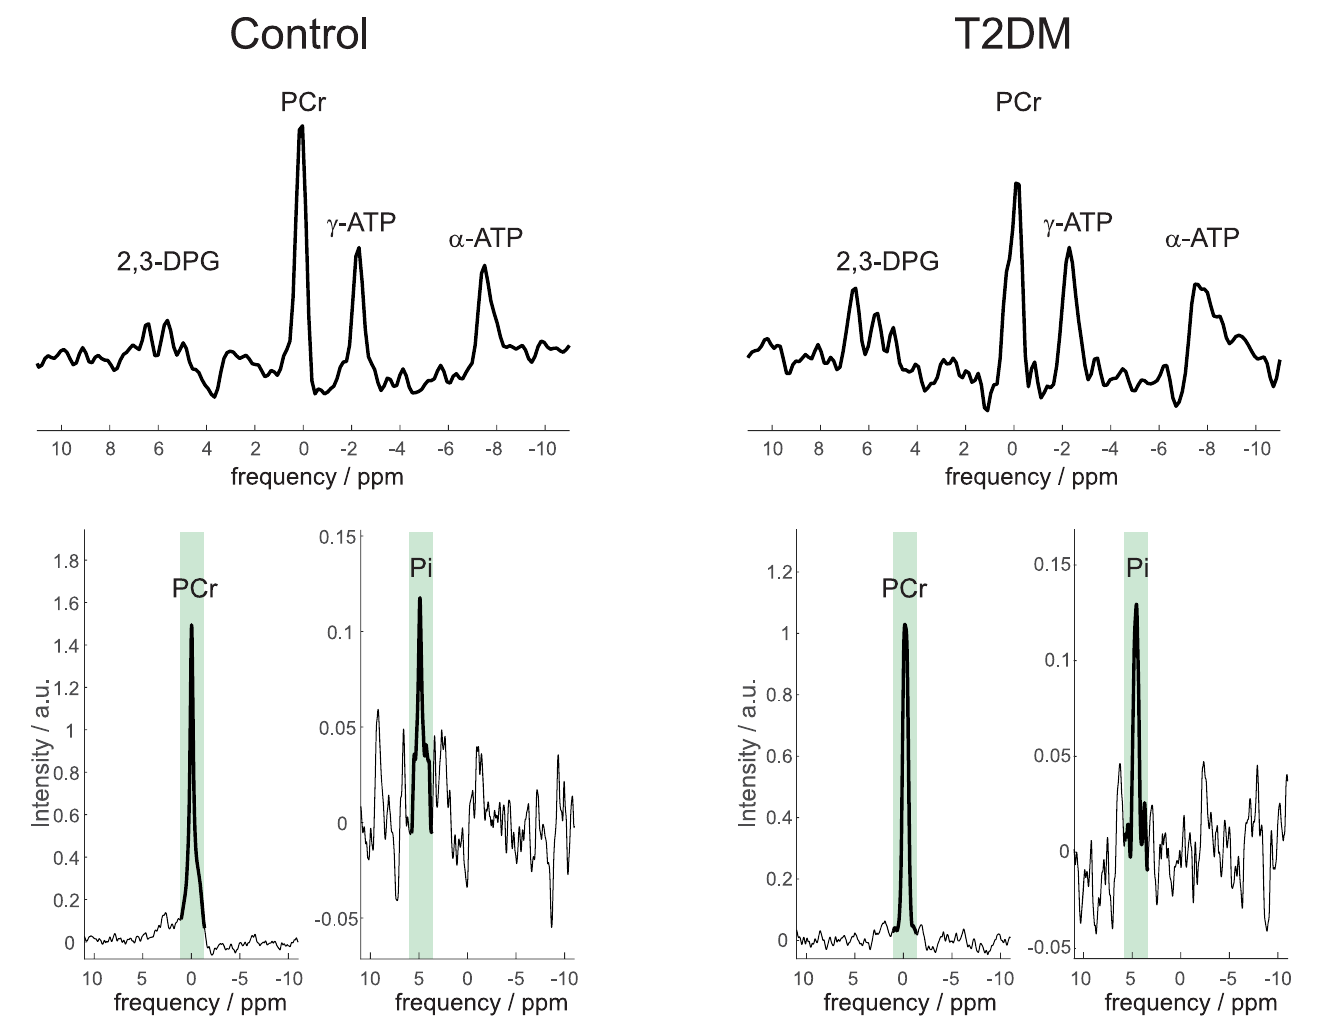
Fig 1. Typical CSI (top) and STEAM (bottom) spectra from a control (left) and a T2DM (right) participant. Please note that the CSI spectra are scaled to ATP amplitude to clearly demonstrate the difference in PCr/ATP. Also, for each STEAM interleave the spectral region targeted and used for the Pi/PCr and pH calculations is highlighted by bolder lines and green background. Increased Pi and decreased PCr can be seen in the T2DM STEAM